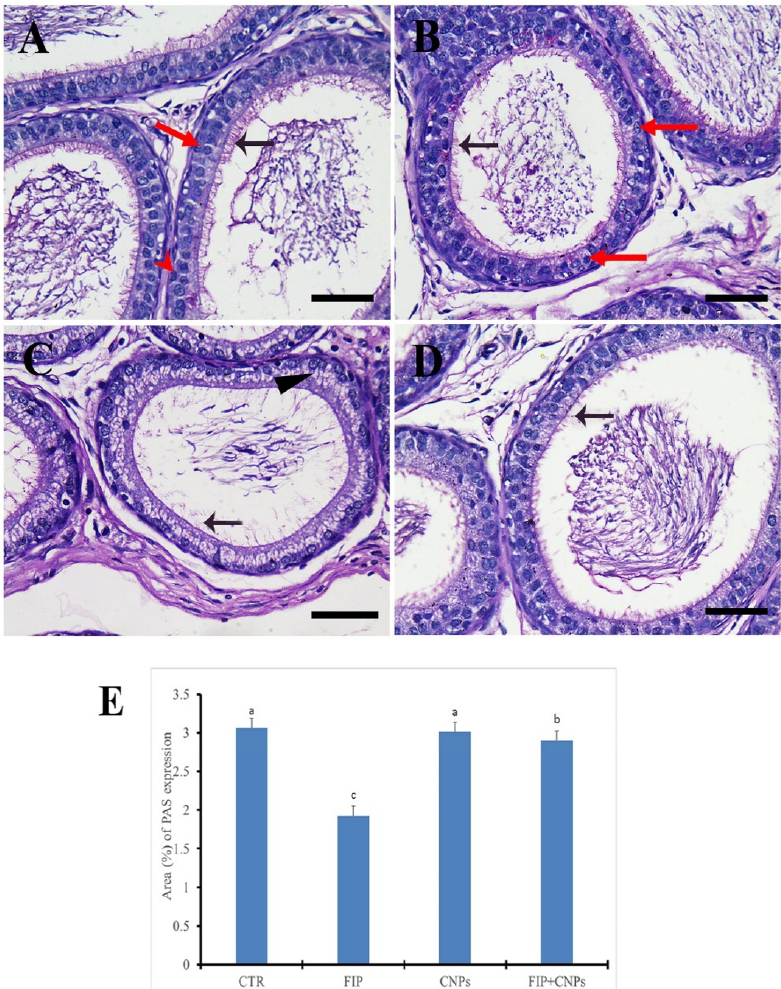
Figure 2. Histochemical staining of rats’ epididymis by Periodic Acid Schi ff (PAS). ( A ) Control group showed normal dense short stereocilia (arrow), principal cell (red arrow), basal cell (red arrow). ( B ) CeNPs group. ( C ) FIP group revealed weak PAS reaction in elongated and dispersed stereocilia (arrowhead) with vacuolated epididymal epithelium (arrow). ( D ) FIP treated with CeNPs showed normal dense short stereocilia (arrow). ( E ) Semi-quantification of PAS in the epididymis in di ff erent groups. Scale bar = 50 µ m. Data expressed as mean ± SE, analyzed using one-way ANOVA at p ≤